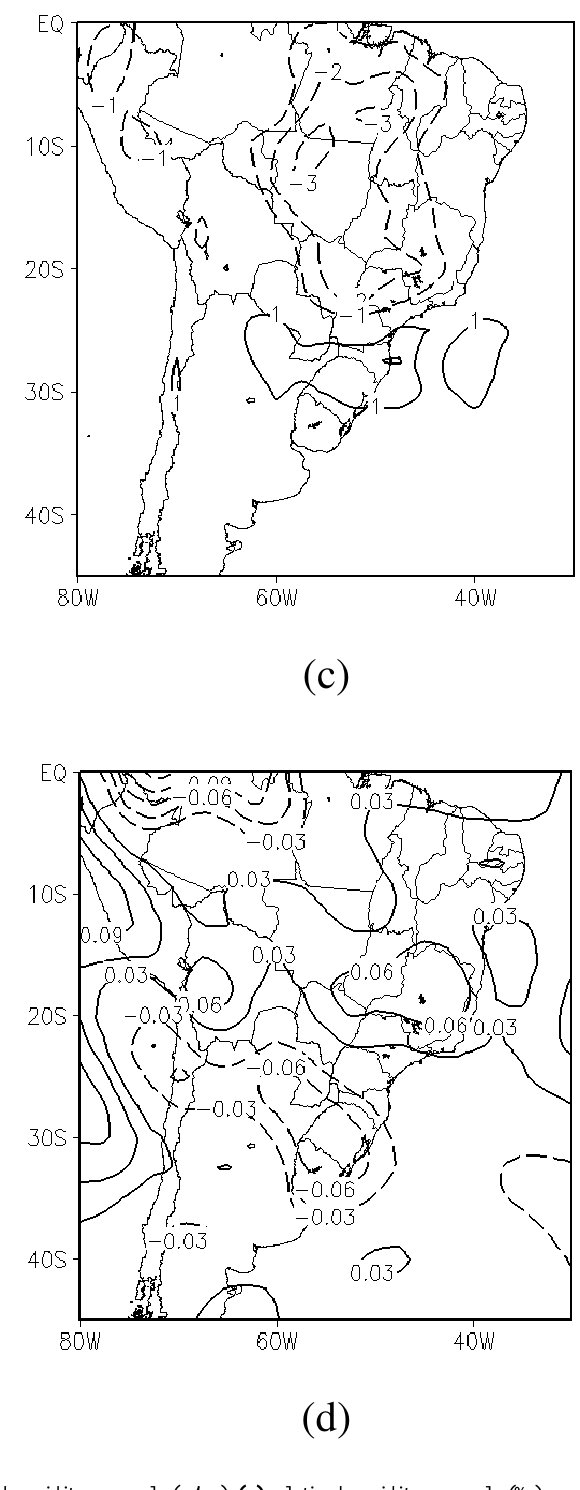
Fig. 5. Composite mean (a) surface temperature anomaly ( ◦ C), (b) specific humidity anomaly (g/kg), (c) relative humidity anomaly (%), and Fig. 5 – Composite mean (a) surface temperature anomaly ( ° C), (b) specific humidity (d) 500-hPa ω (Pas − 1 ) for 17 strong WDSs during anomaly (g/kg), (c) relative humidity anomaly (%), and (d) 500-hPa ω (Pa s -1 ) for 17 strong WDSs during 1961-2003.